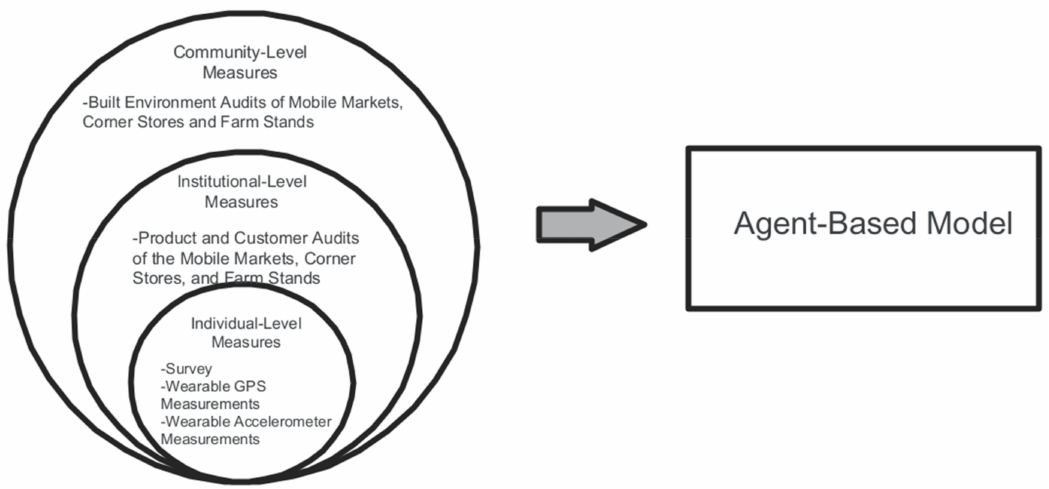
Figure 1. Levels of measurement of the FRESH-Austin